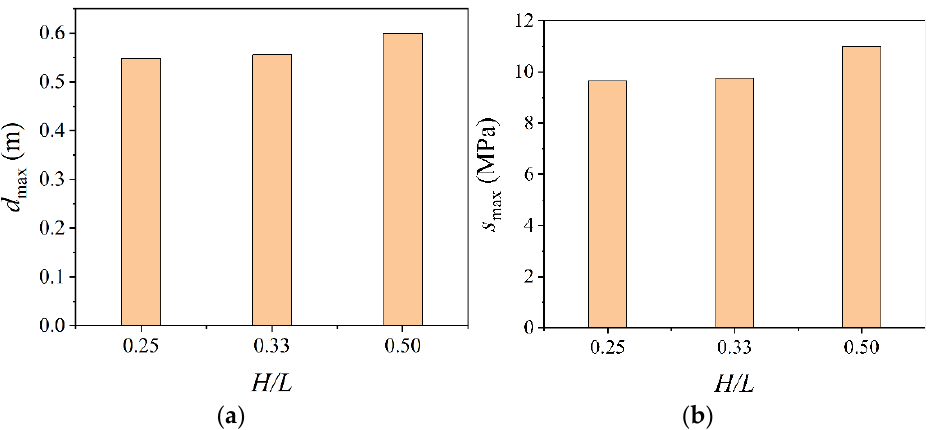
Figure 16. The maximum wind ‐ induced responses with different rise–span ratios ( L = 60 m, p = 300 Pa, U h = 15 m/s): ( a ) Displacement; ( b ) Stress.